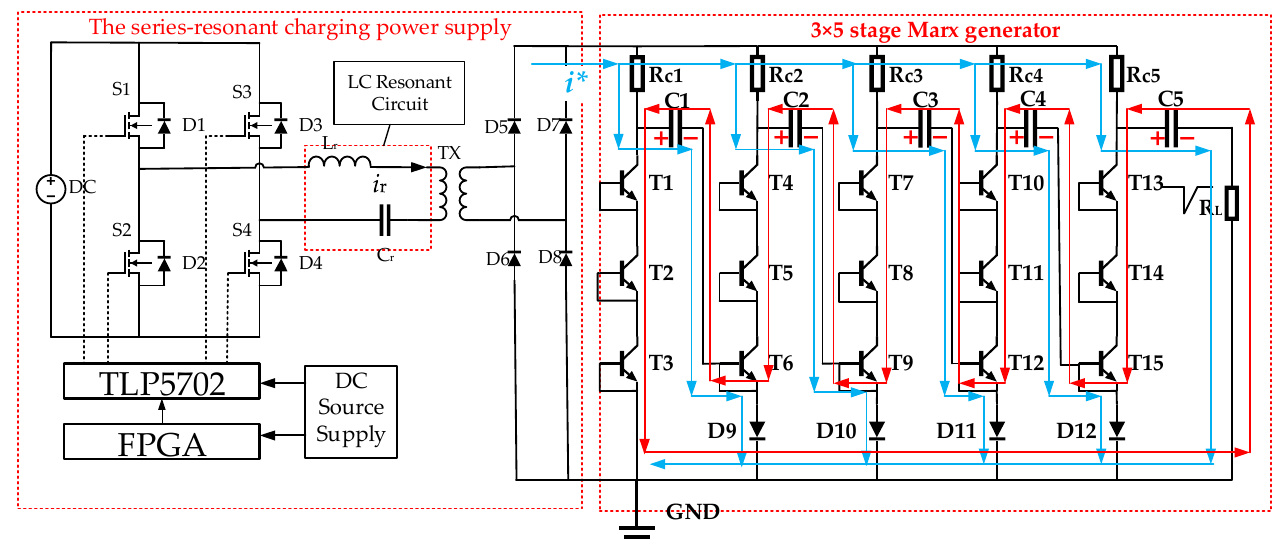
Figure 2. The schematic of the proposed nanosecond Marx generator (circuit Ⅰ ).